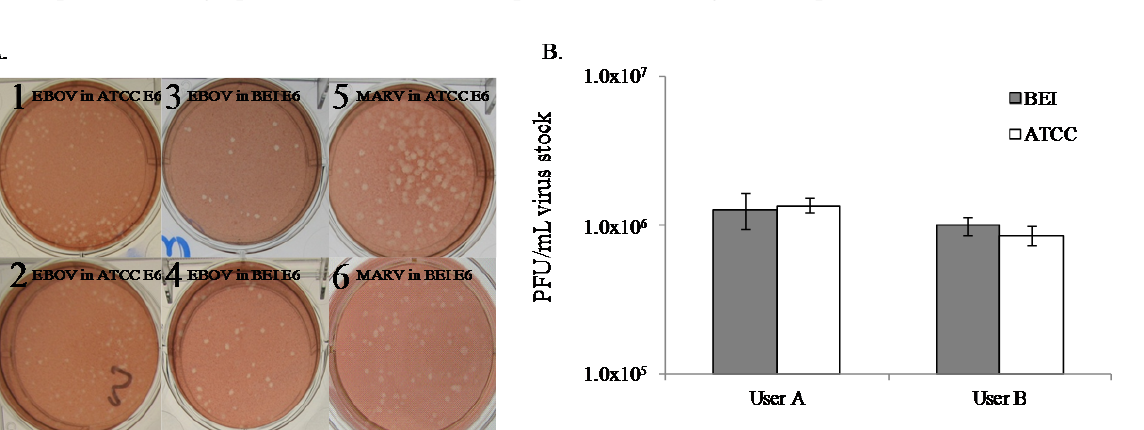
Figure 2. Filovirus plaques produced on Vero E6 cells from two sources are similar in appearance and titer. ( A ) EBOV plaques on ATCC Vero E6 cells plated at (1) 24 hours before assay, and (2) 72 hours before assay. EBOV plaques on BEI Vero E6 cells plated at (3) 24 hours before assay, and (4) 72 hours before assay. (5) MARV plaques on Vero cells from (5) ATCC and (6) BEI plated 24 hours before assay. ( B ) EBOV titers are similar in Vero E6 cells from ATCC and BEI when measured independently by two operators. This experiment was performed twice with up to 3 operators (data not shown), and one representative graph is shown. Each bar represents an average of 7